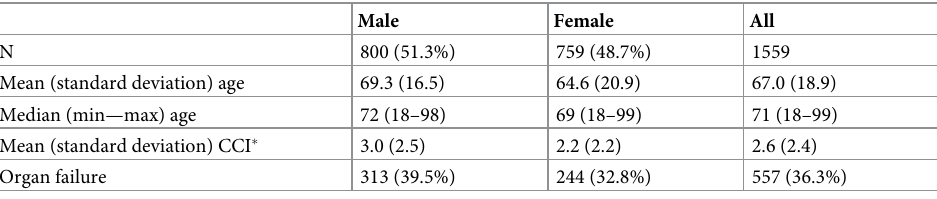
Table 1. Selected characteristics of the study